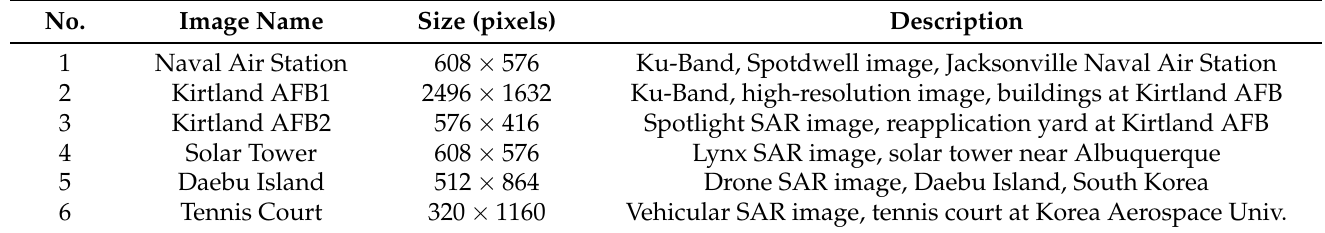
Table 2. SAR images for performance evaluation (the images 1 ∼ 4 are available by courtesy of Sandia National Lab., Radar ISR [51] and the images 5 and 6 are obtained by field measurement in Section 4).